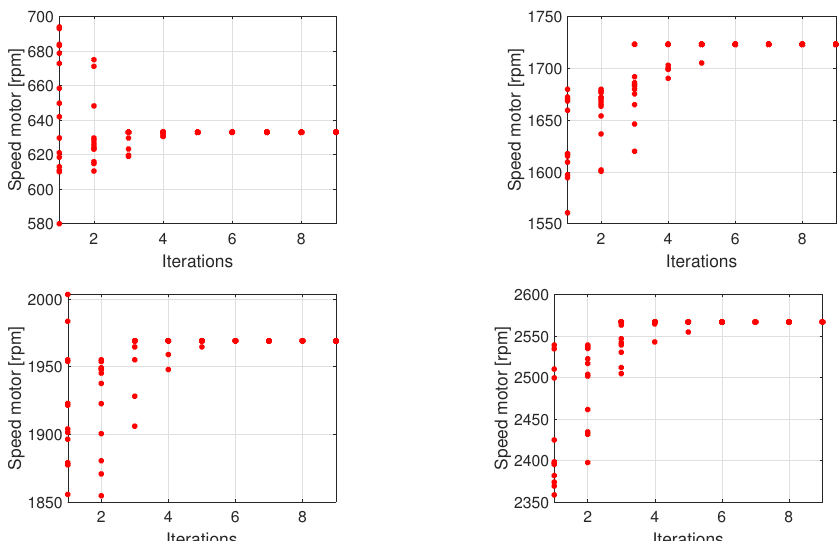
Figure 13. Particles convergence of PSO algorithm in different motor speed